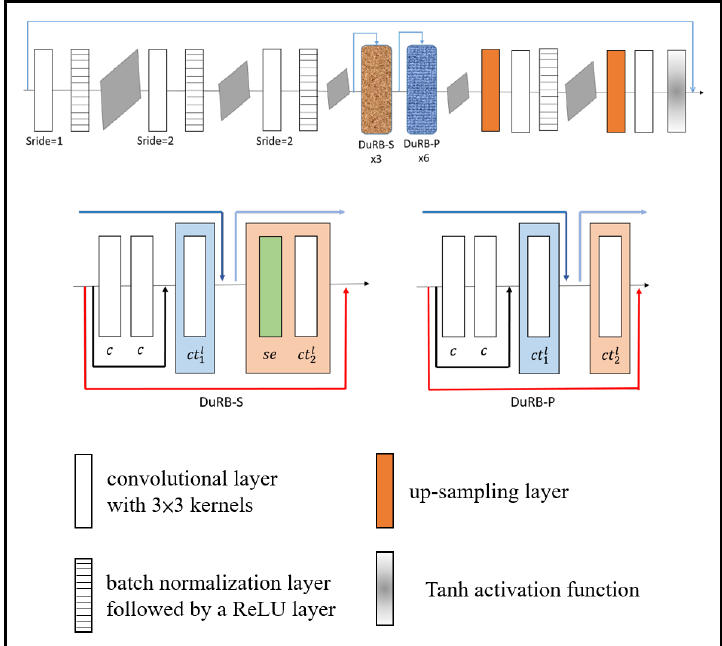
Figure 11. Raindrop removal network structure.